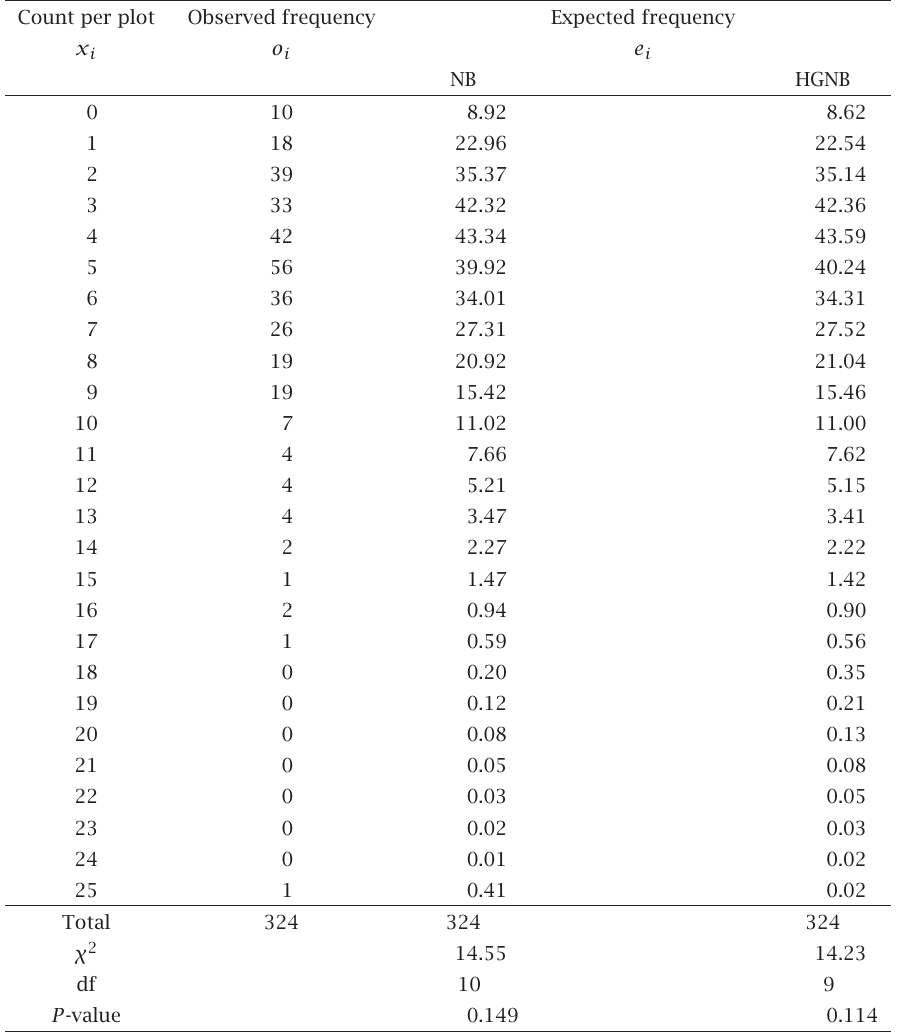
Table 4.2 . Fitting negative binomial (NB) and hypergeometric generalized negative binomial (HGNB) distributions to the frequency distribution of Eu- ropean corn borer larvae Pyrausta nubilalis (Hnb.) in field corn. Count per plot Observed